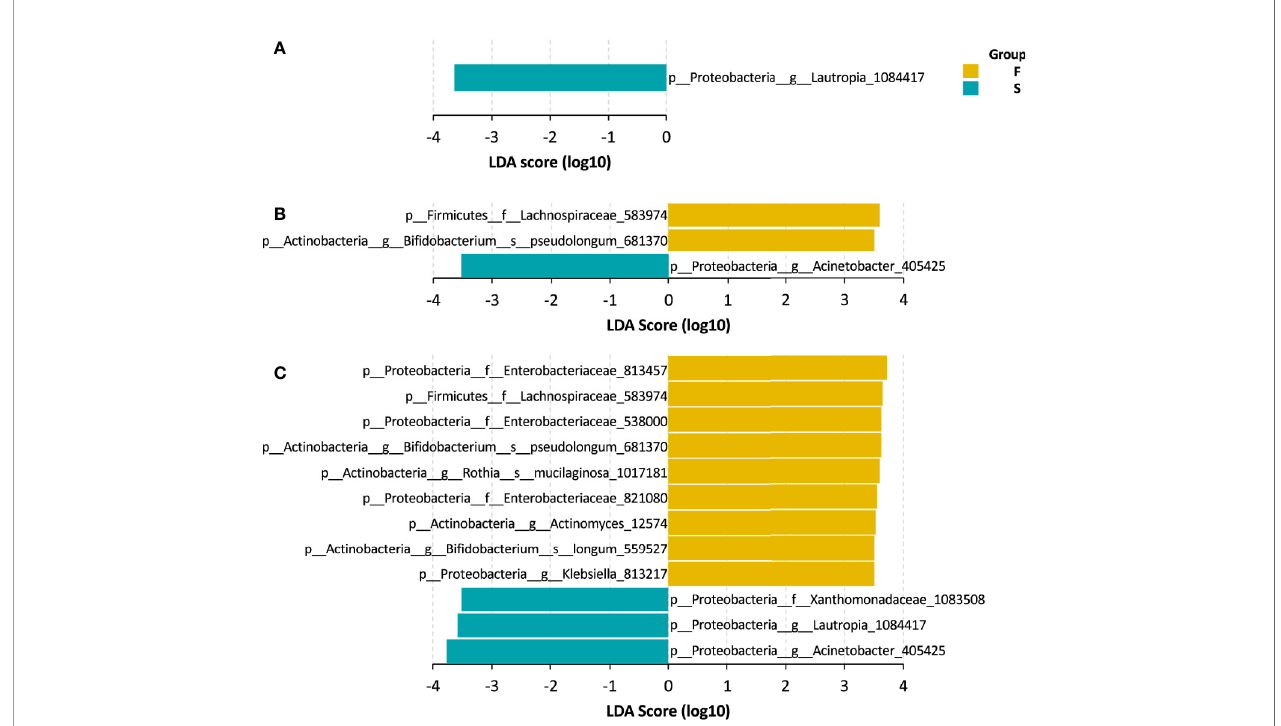
FIGURE 3 | LEfSe bar of the representative taxa in the S and F groups during the treatment course. (A) Baseline. (B) Chemotherapy. (C) During